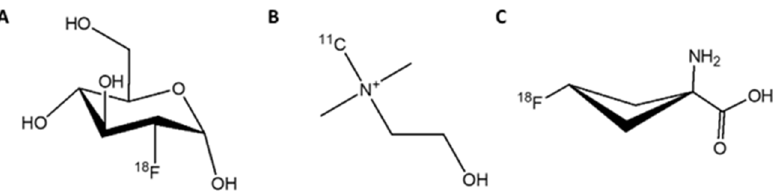
Figure 1. PET tracers approved by the FDA for imaging of PCa that accumulate in cancer cells due to cell division. ( A ) [ 18 F]FDG, ( B ) [ 11 C]choline; ( C ) [ 18 F]fluciclovine ([ 18 F]FACBC).